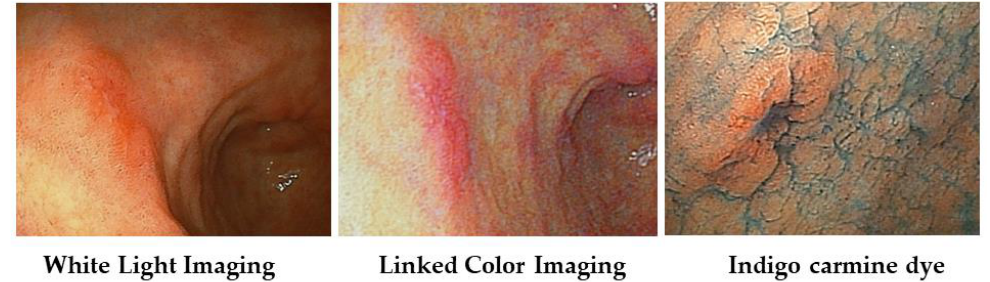
Figure 5. Case of early gastric carcinoma (Type 0–IIc) witn atrophic gastritis. 5.3. Evaluation of LCI for Gastric Carcinoma with CIE 1976 (L* a* b*) Color Space Kanzaki, H., et al., evaluated the color differences between the lesion and the